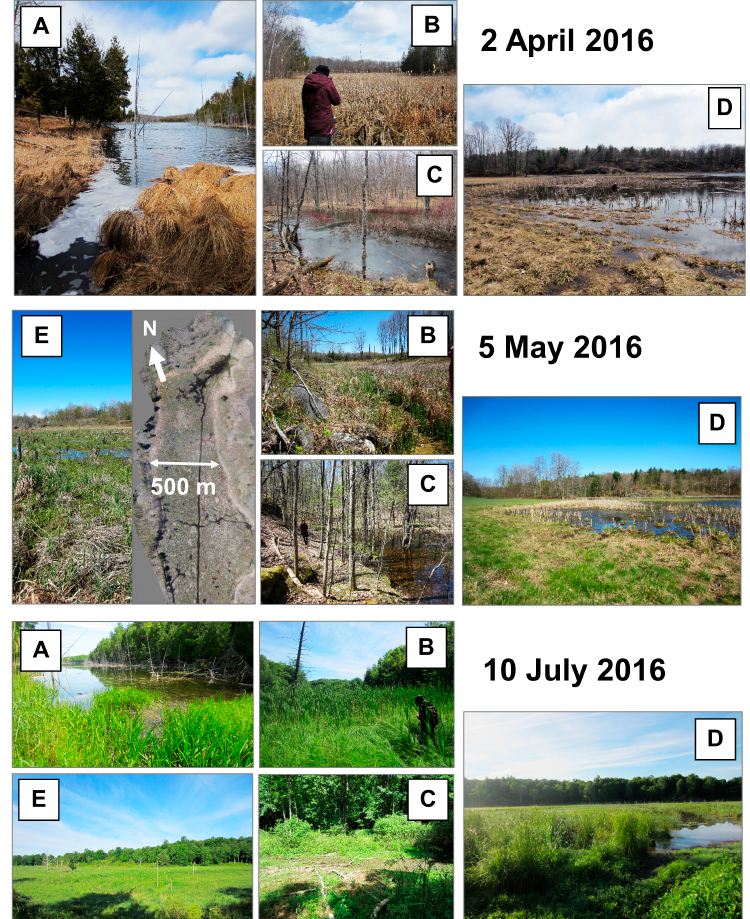
Figure 11. Photographs from in situ fieldwork performed on three of the five SAR acquisition dates: in April, May and July 2016: ( A ) Poole Lake; ( B ) Marsh A; ( C ) Inundated Forest; ( D ) Marsh B; and ( E ) Vegetated Lake. This location was first observed on 5 May and also shows a photogrammetric model created using images captured from UAV.